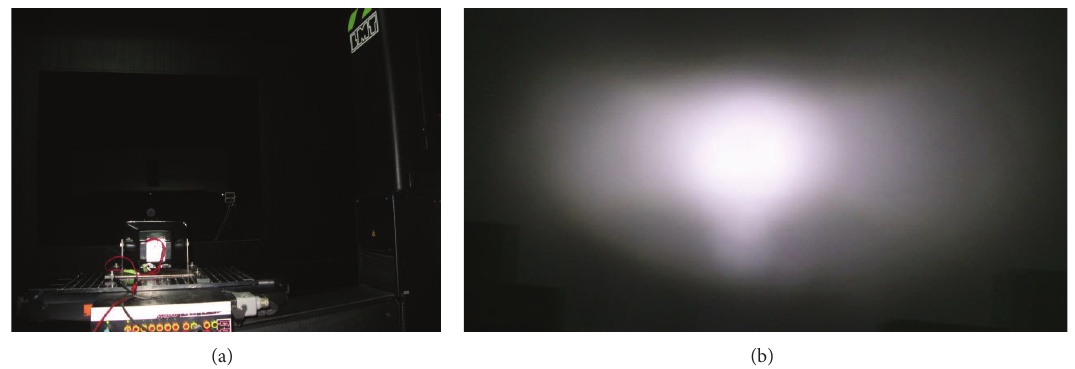
Figure 12: (a) Measured configuration and (b) light pattern of the test results.